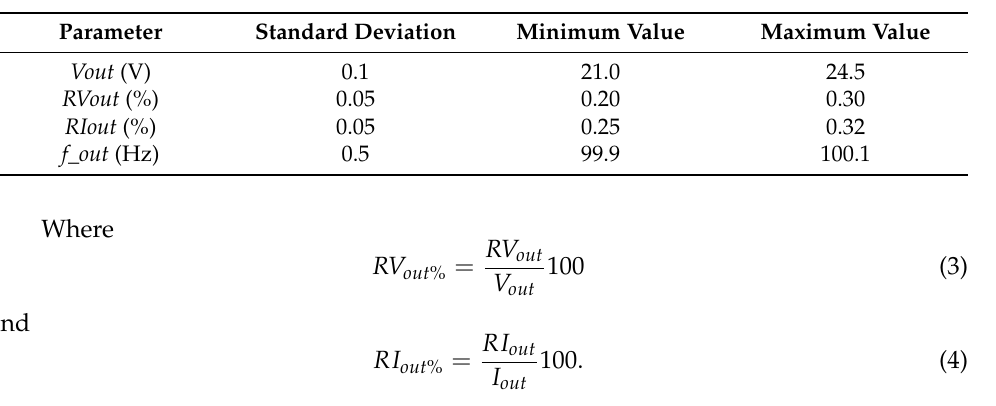
Table 3. Overall experimental values of the quantities of influence.